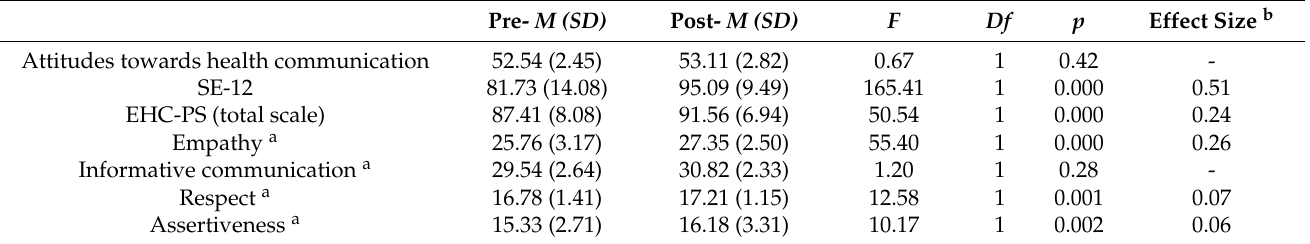
Table 4. Pre-and post-intervention comparisons of the variables assessed in the